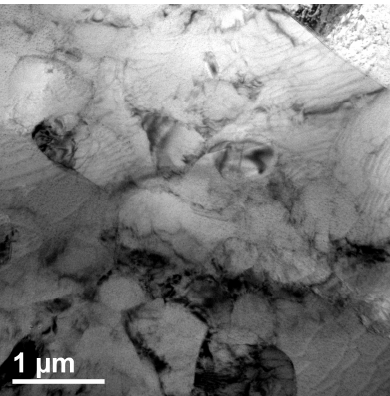
Figure 6. TEM image of the PM-8p-ECAP composite.